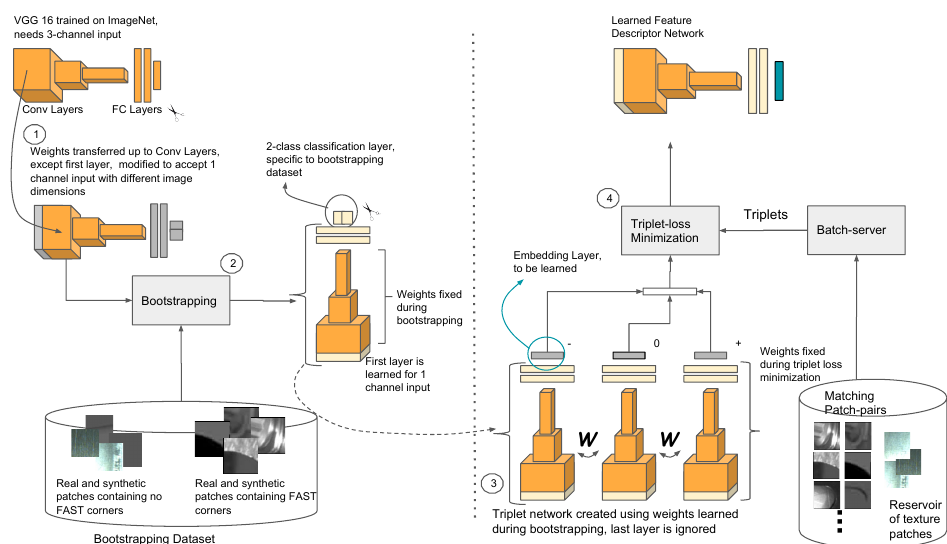
Figure 3. Proposed two-step method for training a deep descriptor using a data set of patches created as described in Figure 2. The first stage (left of the vertical divider), bootstrapping, produces weights such that distinction between domains is removed and the second stage (right of the divider), triplet- loss training, trains an embedding layer on top of the weights learned previously that produces discriminative